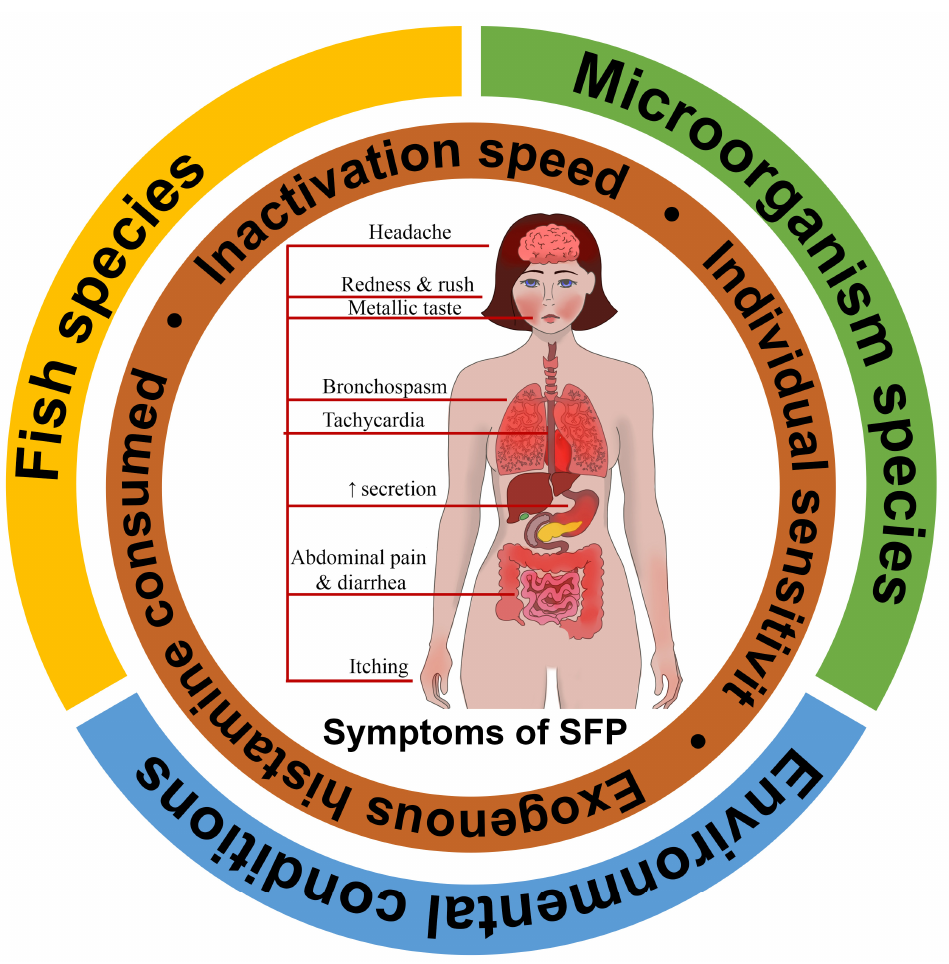
Figure 1. Scombroid food poisoning formula. External contributing factors: fish species, saprophytic microorganism species that convert histidine to histamine, and environmental conditions; Internal individual factors: exogenous histamine consumed, inactivation speed, and individual sensitivity, etc.